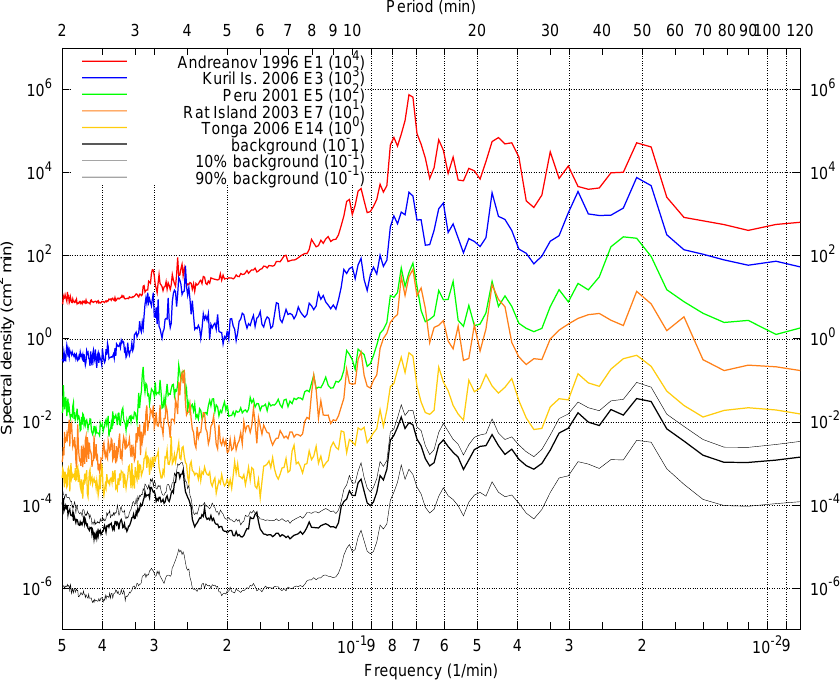
Fig. 4. Spectral analysis of the Adak Island tide gauge records. Sample interval is 1min. The black line is the background spectral density (with no tsunami) averaged over 70 days, with the gray lines representing the corresponding 10th and 90th percentile. The lines above are average spectral densities computed for the Andreanov 1996 (E1), the Kuril Islands 2006 (E3), the Peru 2001 (E5), the Rat Island 2003 (E7), and the Tonga 2006 (E14) events. Spectral densities curves are shifted through an amplification factor to make an easier inter-comparison. Spectral densities are calculated through FFT on 10.5h moving windows over intervals of various length: for tsunamis, such intervals are adapted to the duration of the tsunami signal. Notice that all spectral densities have similar shapes, indicating that local eigenmodes are the dominant factor. The main spectral peaks are around 3–4, 10, 13–14, 16, 21–24, 35 and